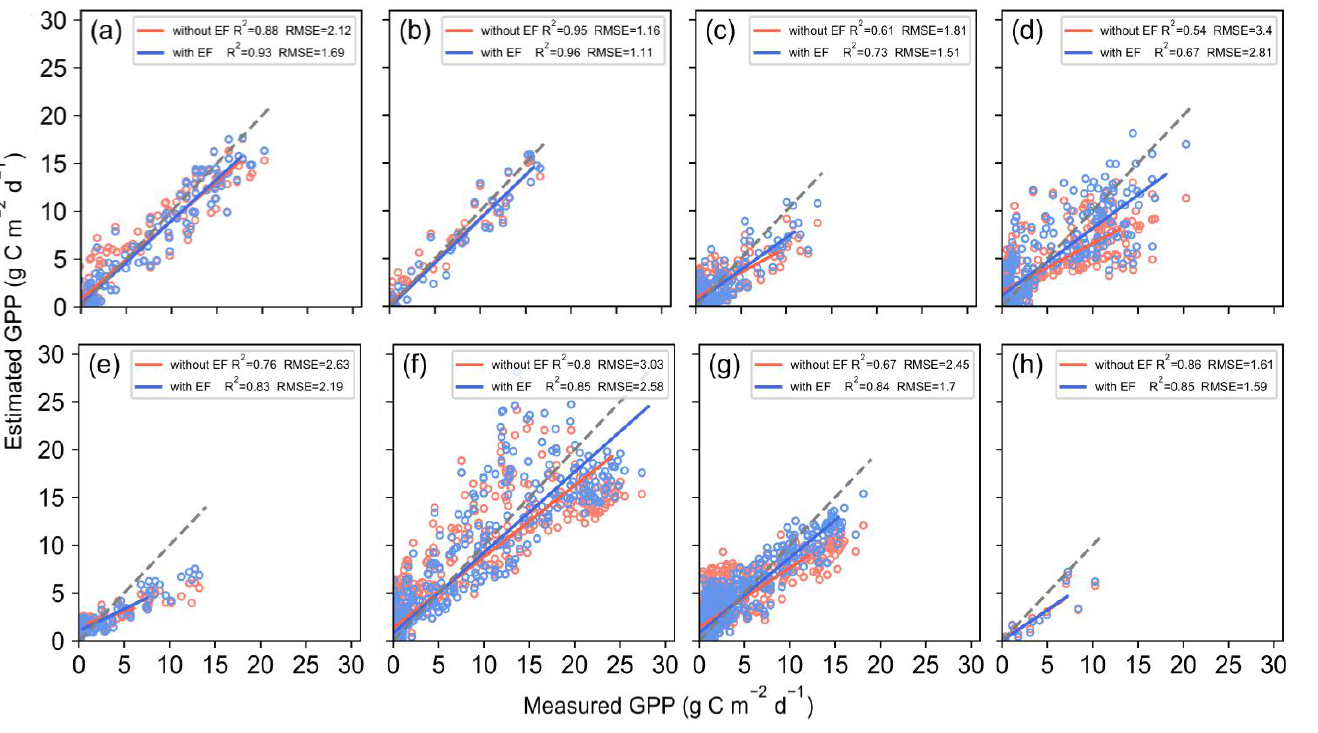
Figure 3. Comparisons between GPP estimated by the model and GPP measured by eddy covariance at cropland flux tower sites (using validation dataset) in the following climate zones: ( a ) BSk; ( b ) BWk; ( c ) Cfa; ( d ) Cfb; ( e ) Csa; ( f ) Dfa; ( g ) Dfb; ( h ) Dfc.